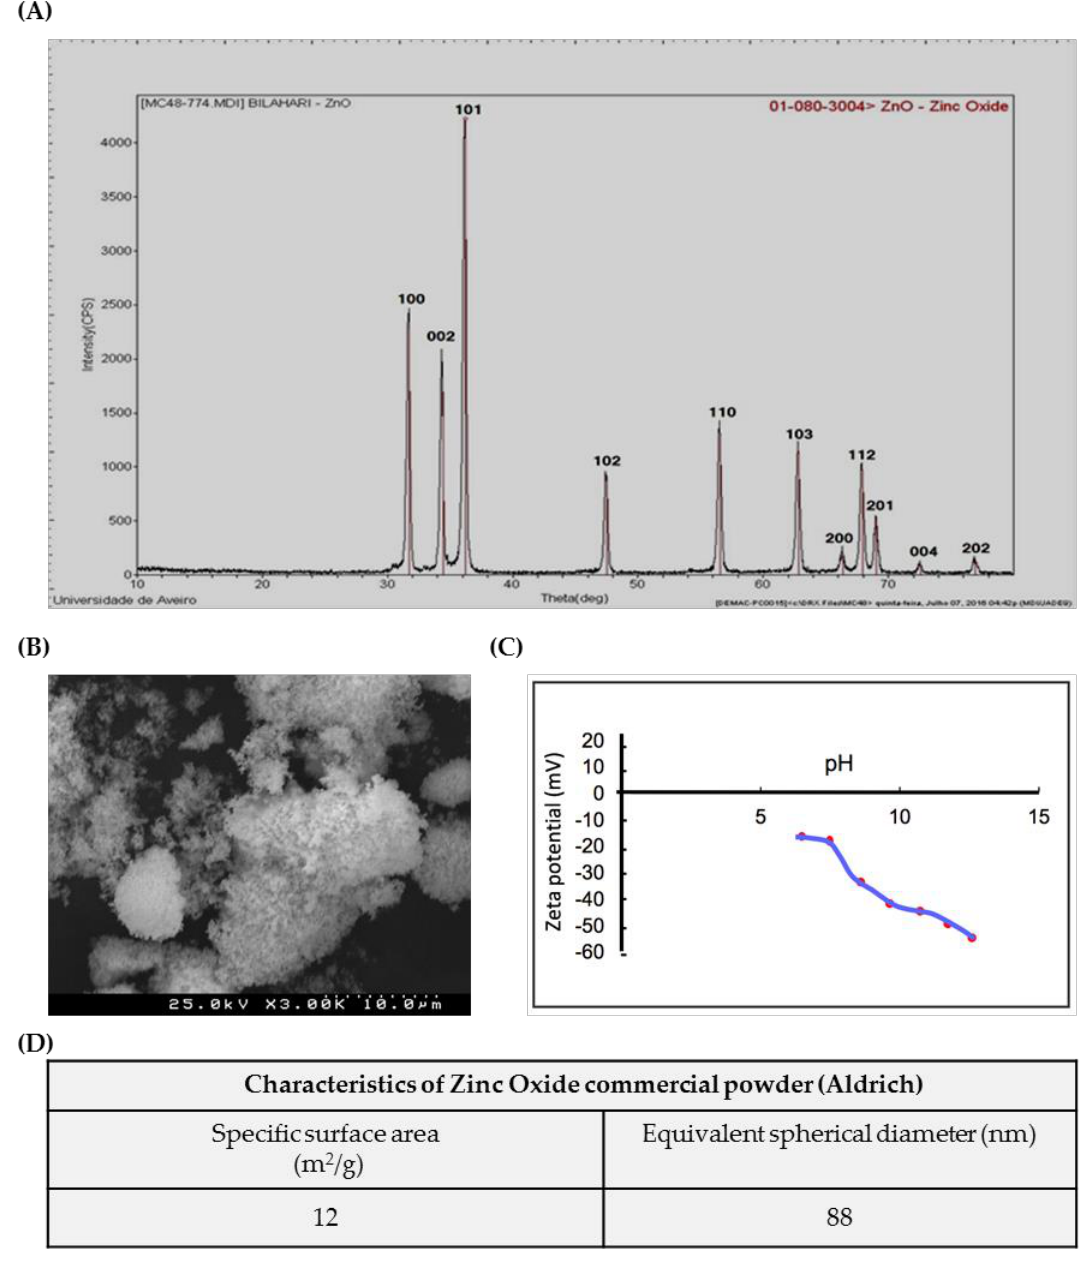
Figure 1. Characterization of ZnO nanoparticles (NPs): Characterization of commercial ZnO powder: ( A ) XRD; ( B ) SEM image; ( C ) Zeta potential curve, and ( D ) table summarizing the morphological characteristics. XRD—X-ray diffraction; SEM—Scanning electron microscopy.